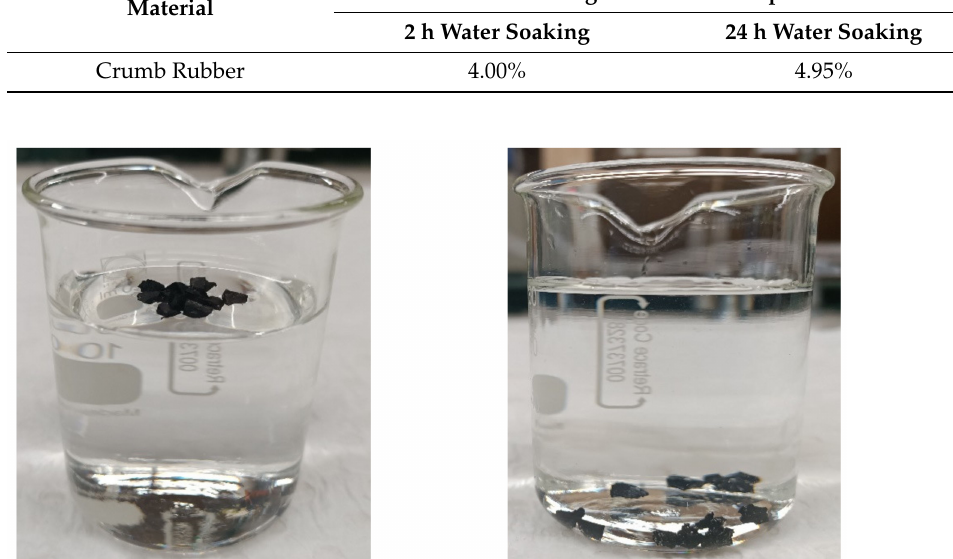
Figure 2. Pictures showing the crumb rubber freshly dropped onto the surface of water ( left ) and the rubber submerged in water after it displaces the air absorbed/adsorbed by the rubber particles with the water molecules ( right